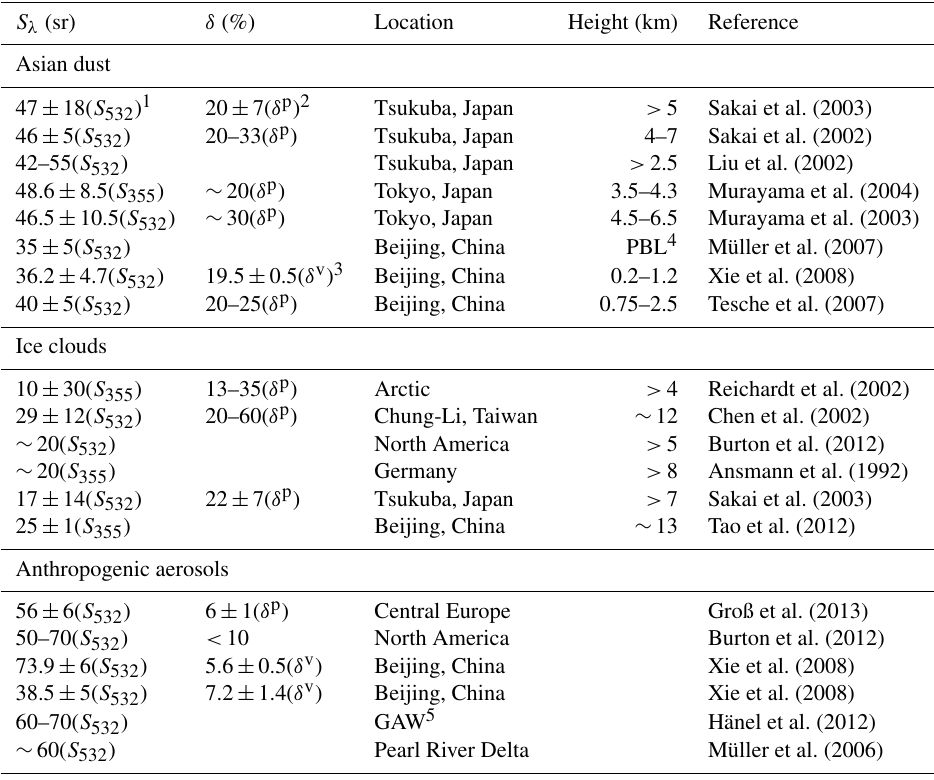
Table 3. RL parameters for Asian dust, ice clouds, and anthropogenic